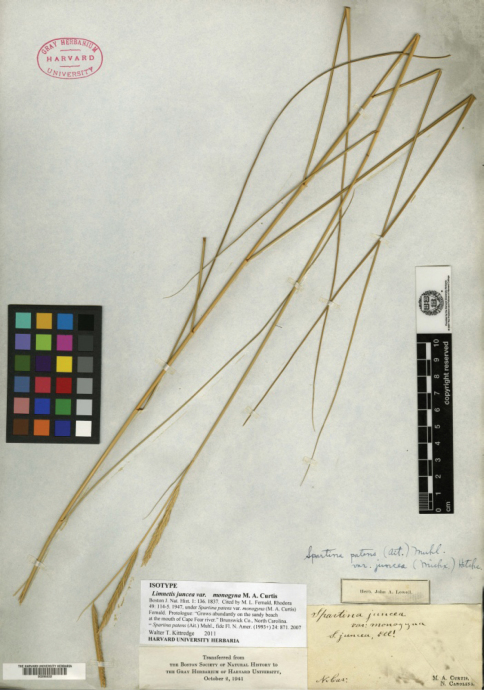
Holotype specimen of Limnetis juncea var. monogyna (Curtis s.n., GH [GH00295532]). Photo: Gray Herbarium of Harvard University Herbarium.